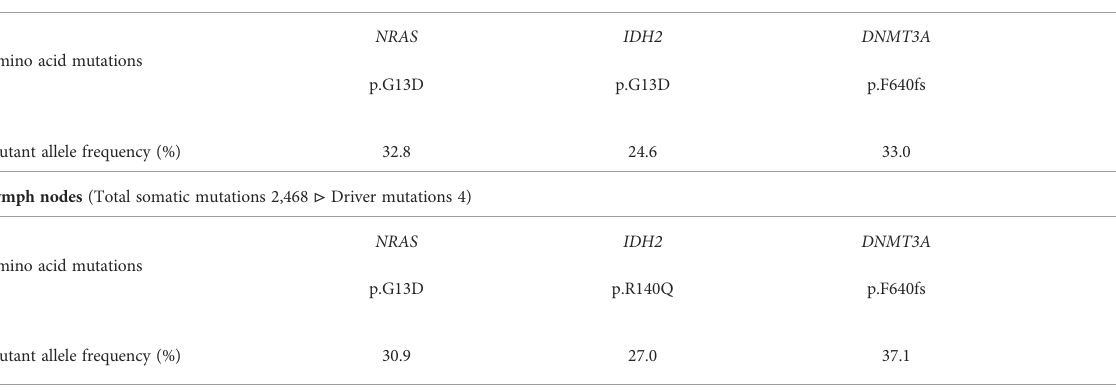
TABLE 1 Results of genomic analysis of cervical lymph node biopsy and bone marrow aspiration by panel analysis. Bone marrow (Total somatic mutations 3,885 ⊳ Driver mutations 4)